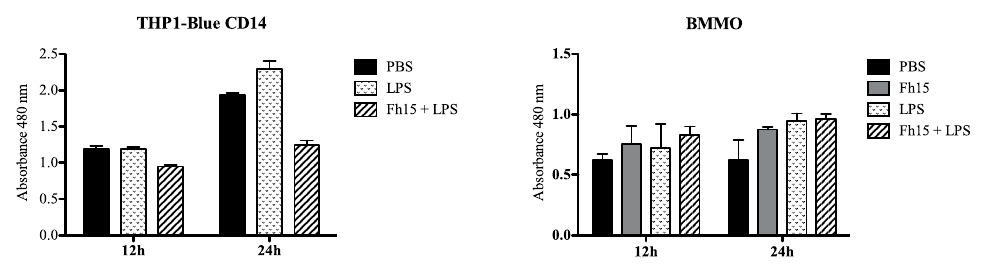
Figure 8. Cell viability. Mouse BMDM and THP1-Blue CD14 cells were exposed to Fh15, LPS or Fh15 + LPS during 12 or 24 h. Cell viability was determined by adding 50 μ l XTT to each well. After an additional incubation of 24 h at 37 °C the absorbance of each well was read at 480